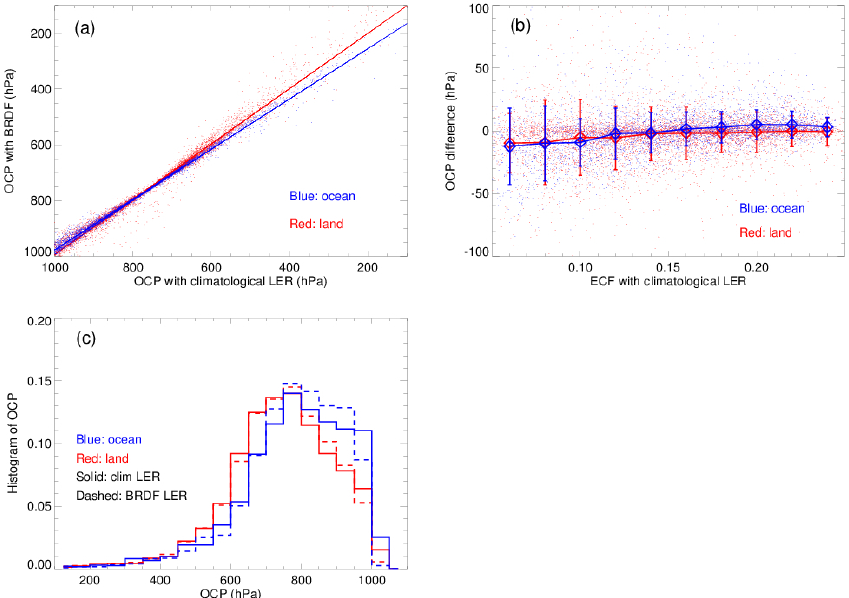
Figure 8. Comparison of RRS-retrieved OCPs computed with geometry-dependent and climatological LERs for OMI orbit 12414 of 14 November 2006; data are for 0 . 05 < ECF < 0 . 25. (a) Scatter plot with regression lines; (b) the mean OCP difference and the standard deviation; (c) normalized histograms of